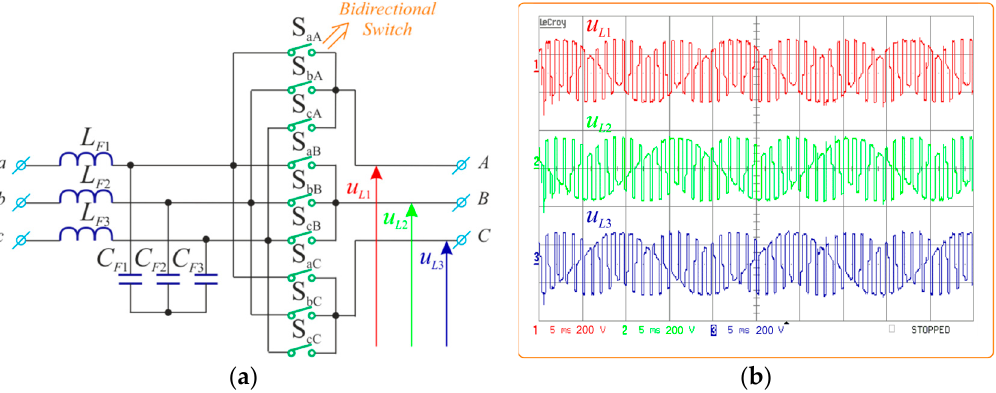
Figure 4. Matrix converter: ( a ) main circuit; ( b ) voltage time waveforms.